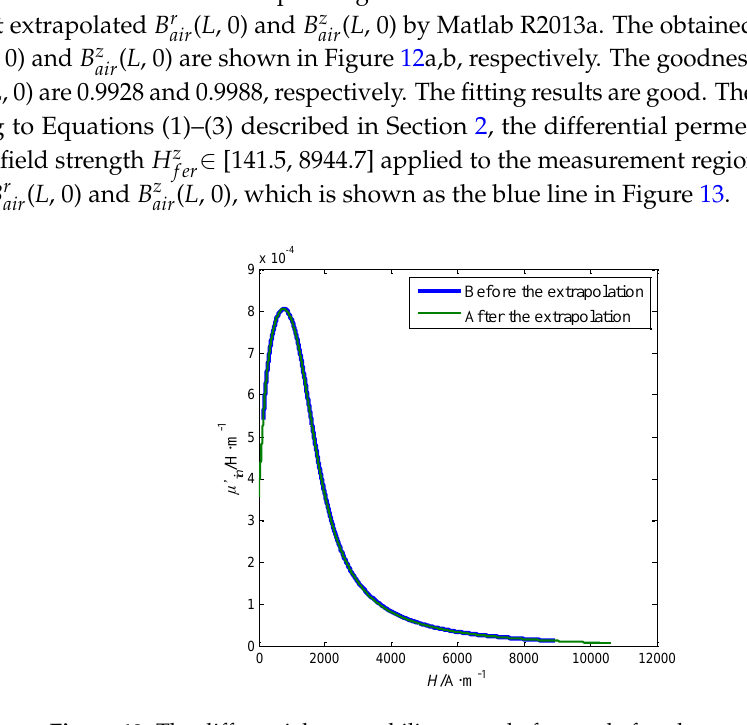
Figure 12. The extrapolated radial ( a ) and axial ( b ) magnetic flux densities at the interface and the corresponding fitting lines.